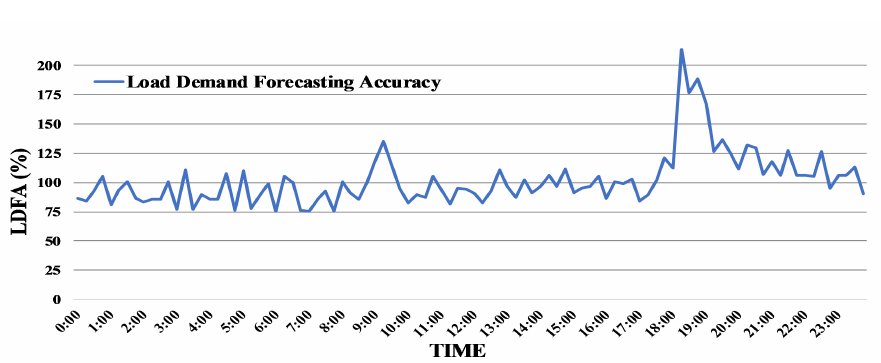
Figure 8. Load Demand Forecasting Accuracy on the 23 August 2019.